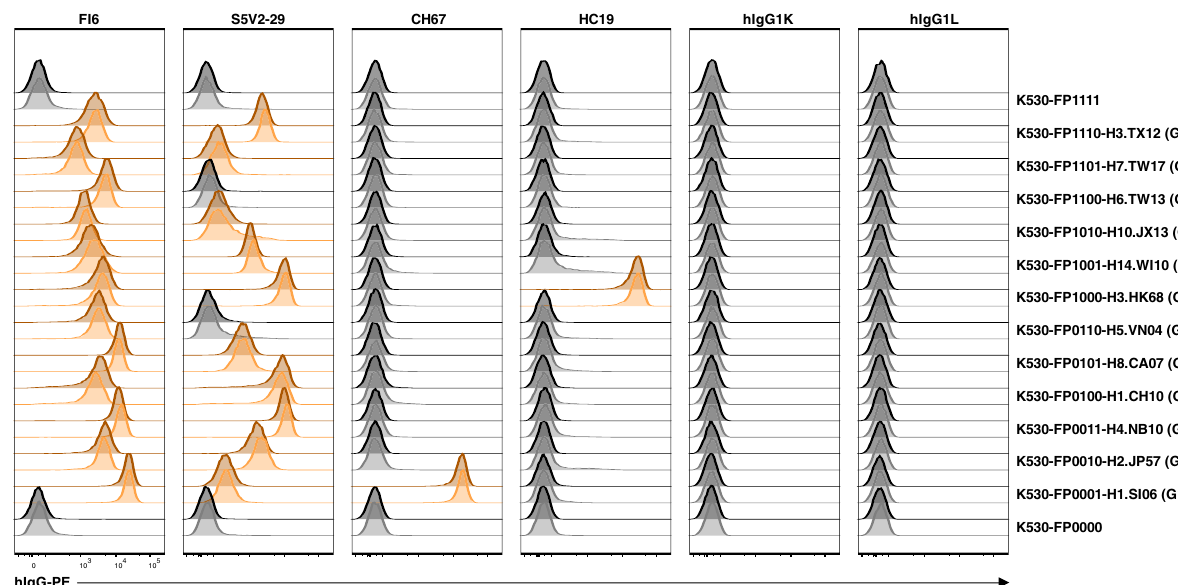
Fig. 2 Cell surface expression of in fl uenza A HA antigens and multiplex detection of binding by reference antibodies. FP-barcoded reporter cell lines were transduced to express a panel of in fl uenza A HA antigens of diverse subtypes. Multiplex binding assay was carried out with pooled cell lines. Reference antibodies of human IgG1 isotype were used at 6 µ g/ml. hIgG1K and hIgG1L, human IgG1 isotype controls with κ - and λ -light chains, respectively. The binding to each reporter cell line was demultiplexed as shown in Fig. 1. Histograms with MFI values above twofold of the average MFI of internal control cell lines (K530-FP0000 and K530-FP1111) were scored as positive and highlighted in orange. Data from two independent experiments were overlaid, with one experiment shown in light gray or light orange and the other in dark gray or dark orange. H1.SI06, A/Solomon